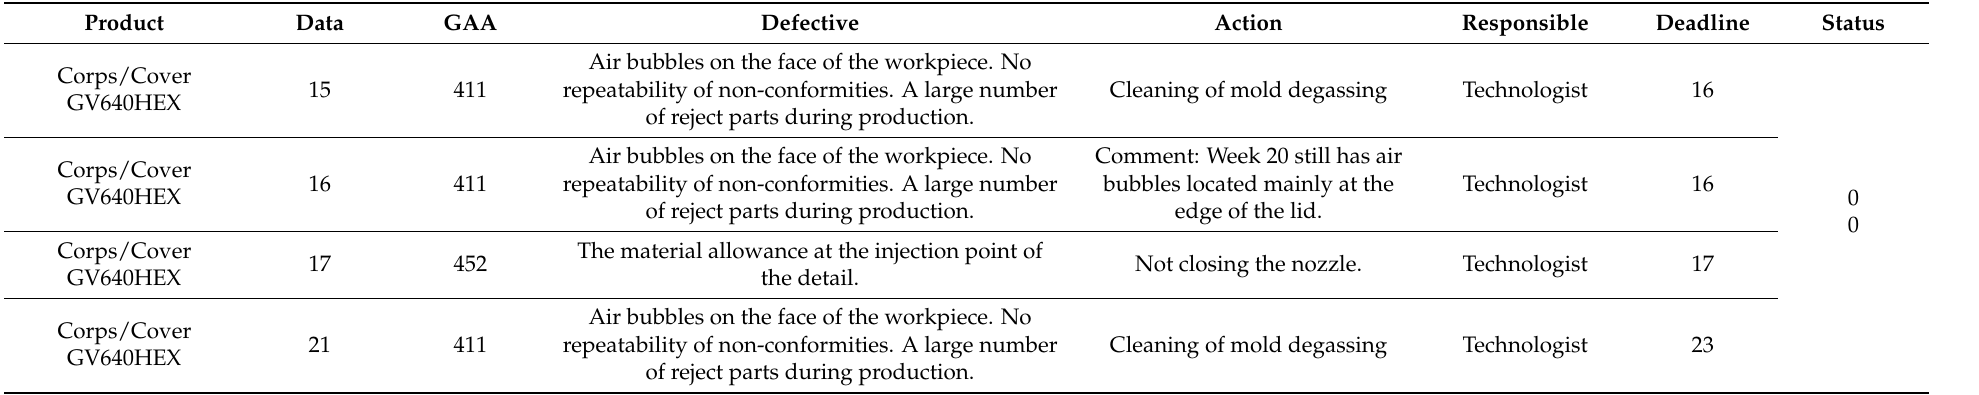
Table 5. GAA analysis—actions in open status—no actions were